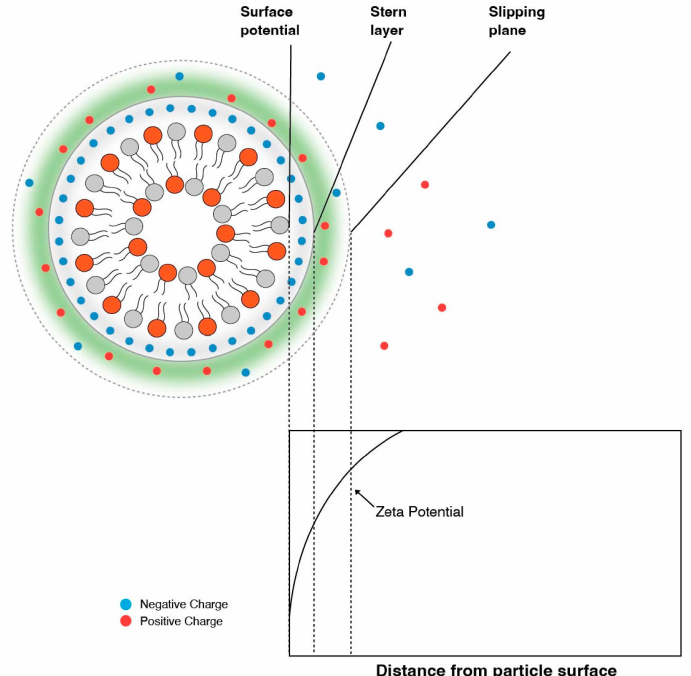
Figure 4. The zeta potential is the potential at the slipping plane and tends to be higher (or lower) than the potential at the